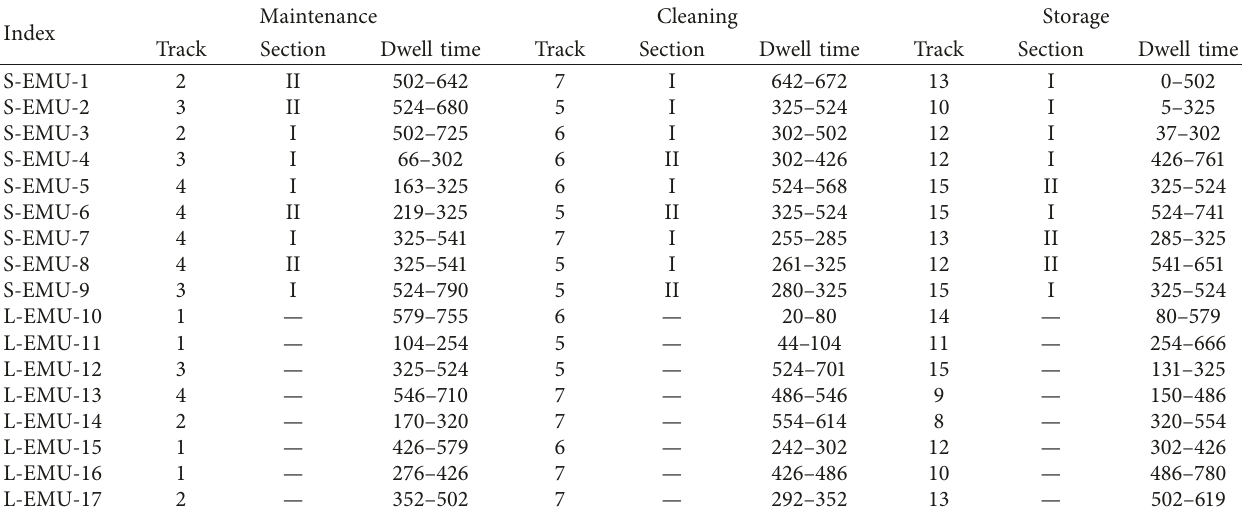
Figure 7: A Gantt chart representation for the optimized shunting plan generated by CPLEX at the through EMU depot. Table 5: The shunting operation plan generated by CPLEX at the stub-end EMU